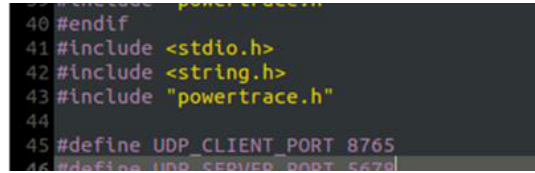
Figure 4. “powertrace.h” library in the mote code. Figure 4 . “powertrace.h” library in the mote code .